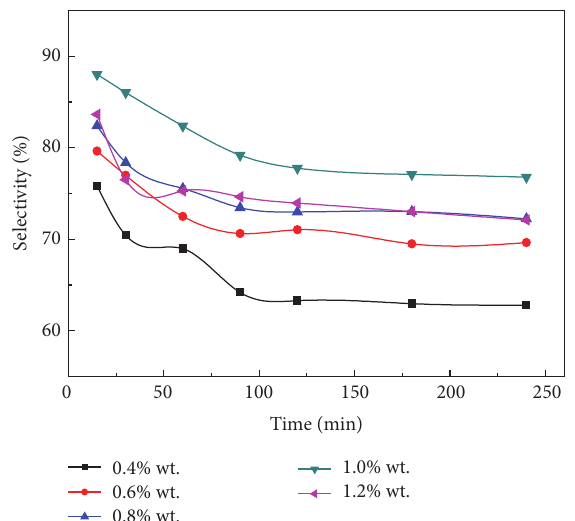
Figure 6: The hydrogen-oxygen selectivity of Pd/Al 2 O 3 in catalytic dehydrogenation reaction.